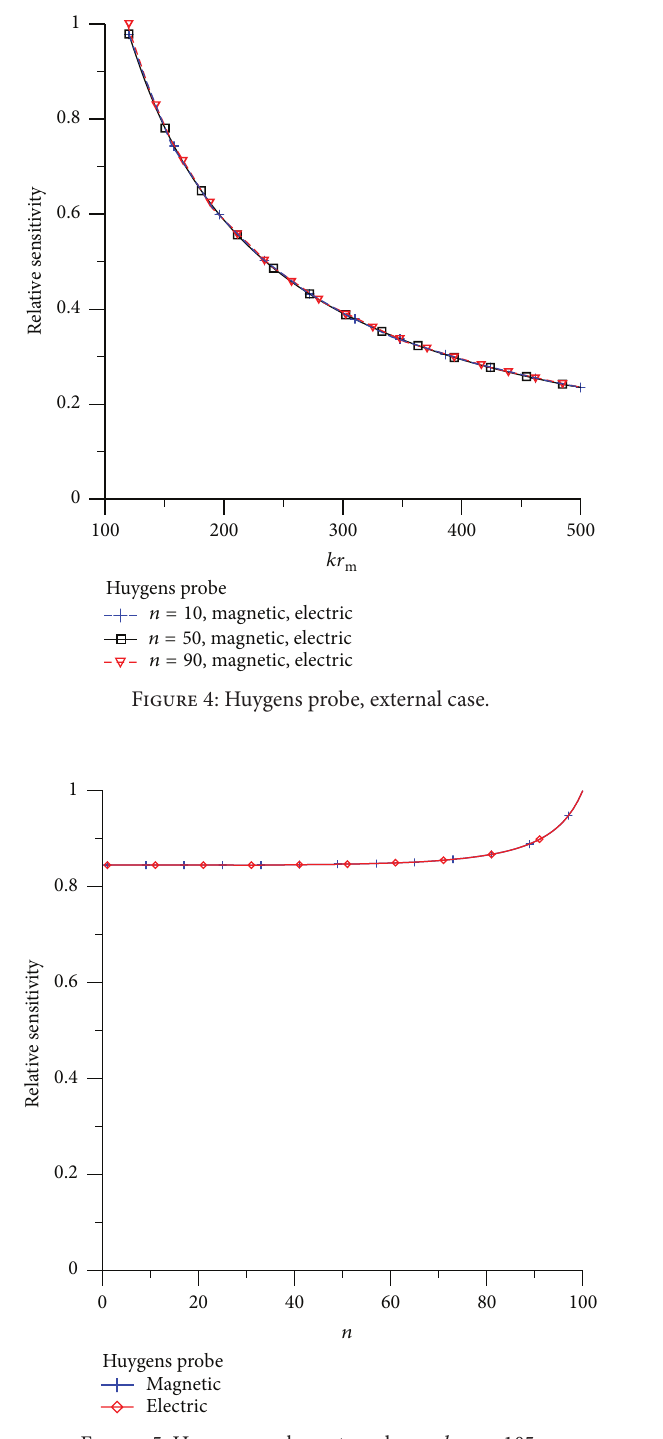
Figure 7: SN 330, external case. = 105 . Figure 5: Huygens probe, external case, 𝑘𝑟 m ℓ 𝑘𝑟 plots 𝛼 for several values of 𝑛 and 𝑛 as a function of m indicates a tendency for conditioning to improve as 𝑟 one or several values of 𝑟 would allow reliable determination m increases. Figure 19 shows 𝛼 ℓ 𝑛 as a function of 𝑛 for 𝑘𝑟 of all of the modes. Figure 17 plots 𝛼 ℓ 𝑛 as a function of 𝑛 for = 104.6 . At this radius, 𝑐 = 830 . 𝑘𝑟 At this radius, 𝑐 𝛼 = 2.8 𝛼 m